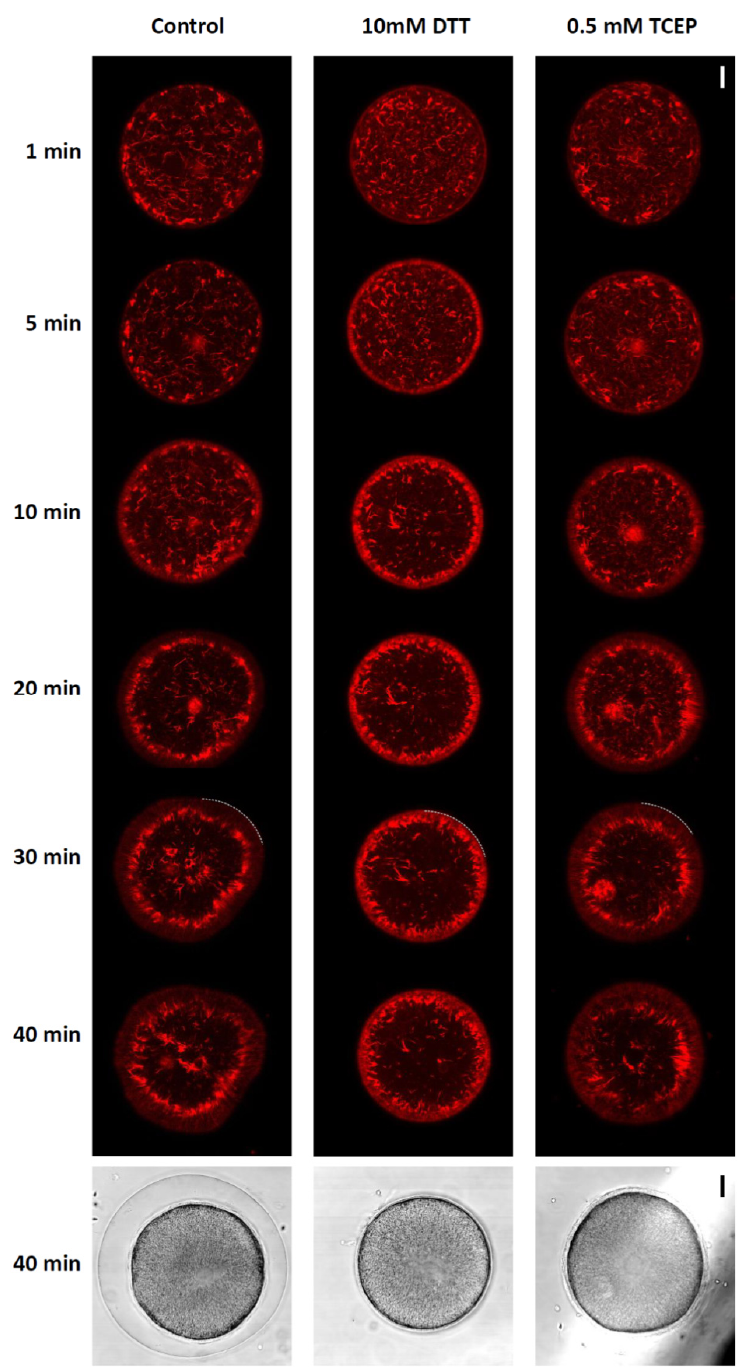
Figure 5. F-actin mobilization during egg activation is inhibited by DTT, the membrane-permeant reducing agent. P. lividus eggs were microinjected with F-actin dye, AlexaFluor 568-phalloidin, and preincubated in seawater in the presence or absence (control) of 10 mM DTT for 10 min prior to fertilization. For comparison, some of the control eggs were exposed to another type of reducing agent that does not penetrate cell membrane, tris(2-carboxyethyl)phosphine (TCEP). The changes of the actin cytoskeleton following fertilization were monitored by confocal microscopy at intervals. The moment of insemination was set as t = 0. The white dotted curves drawn on the images at 30 min delineate the borders of the egg surface. To visualize the fertilization envelope, the same AlexaFluor 568-phalloidin eggs were shown in the bright field view 40 min after insemination. These images are representative of at least two independent experiments. Scale bar, 10 µ